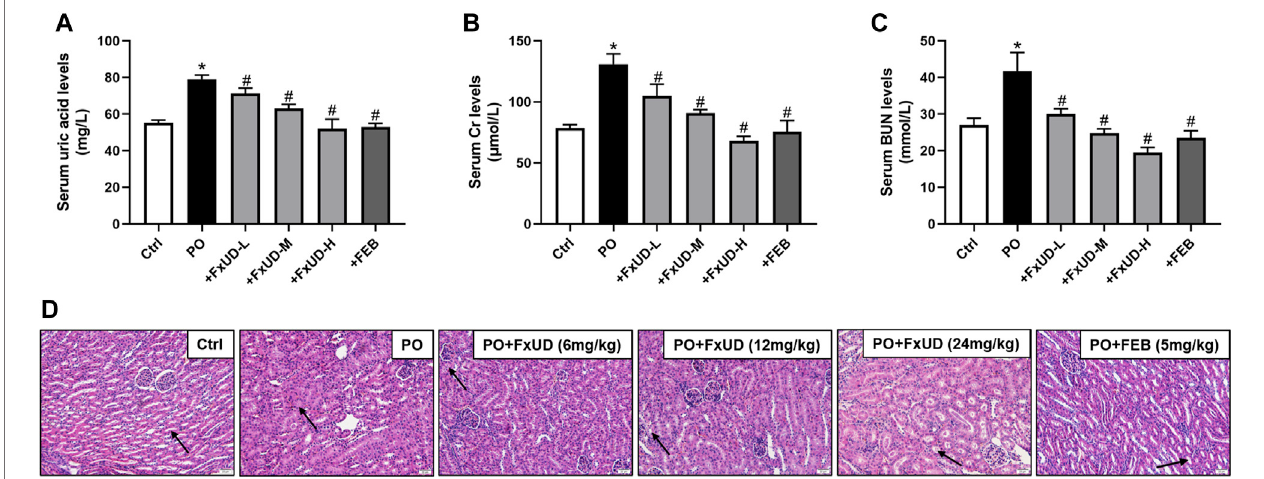
FIGURE2 | FxUDreducesserum uric acid levels and restoresrenal functionin hyperuricemic mice. (A) Uric acid, (B) Cr and (C) BUN levels in serum from themice ( n (cid:1) 8). (D) The representative pictures of renal histopathology in each group ( n (cid:1) 4). Kidneys in control group maintained anormal renal tubular structure (arrow) with no evidence of in fl ammation, kidneys in PO group exhibited inconspicuous boundaries between adjacent tubule cells and swelling, while regulated tubule cells and the cytoplasm were relatively clear in kidneys of high-dose FxUD or FEB treatment group. Magni fi cation 200 × , scale bar 20 µm. Values are expressed as the means ± SD. * p < 0.05 vs. Ctrl, # p < 0.05 vs. PO. Ctrl, control; PO, potassium oxonate; FEB, febuxostat; Cr, creatinine; BUN, urea nitrogen.